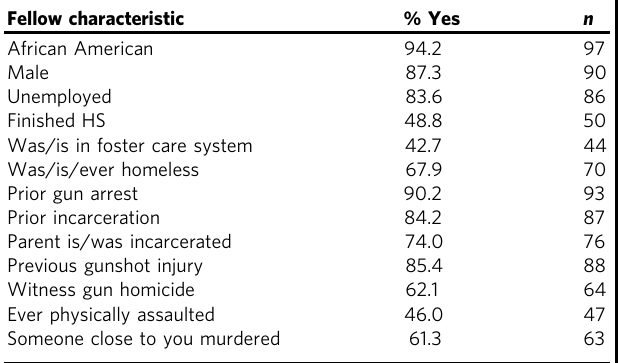
Table 2 Advance Peace Sacramento, participants post- fellowship a